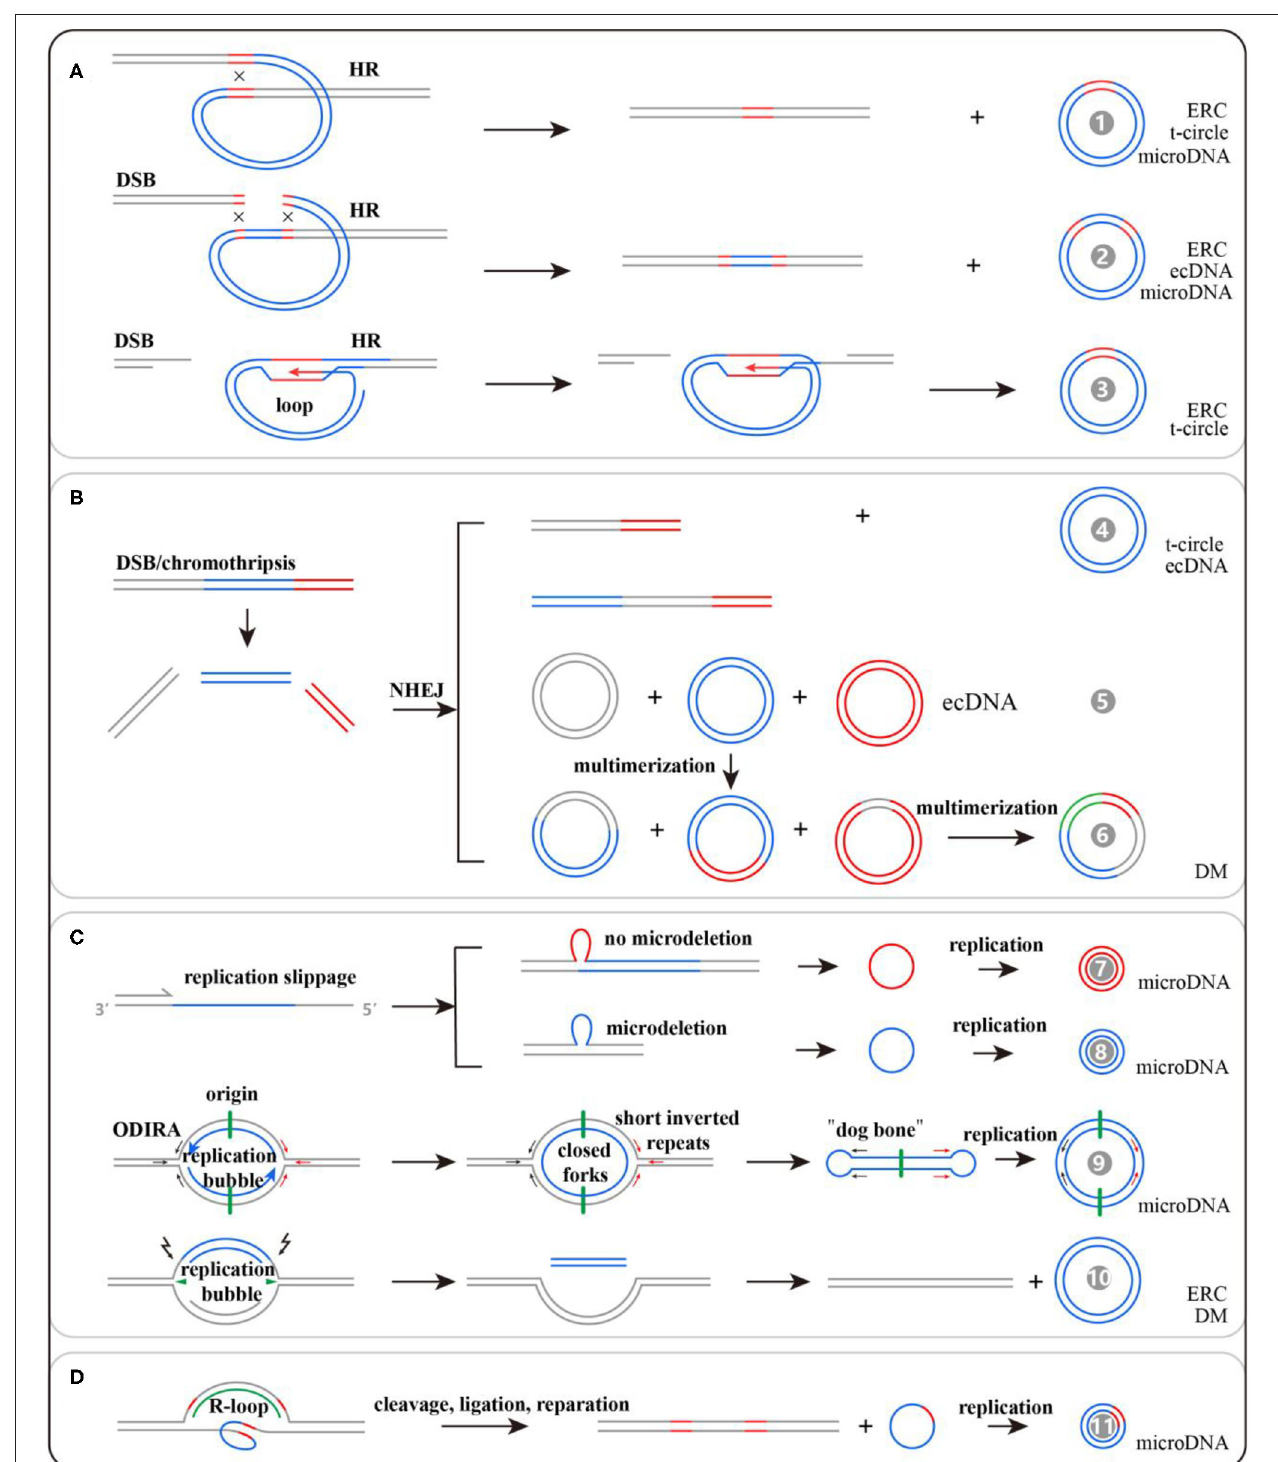
Frontiers in Veterinary Science |